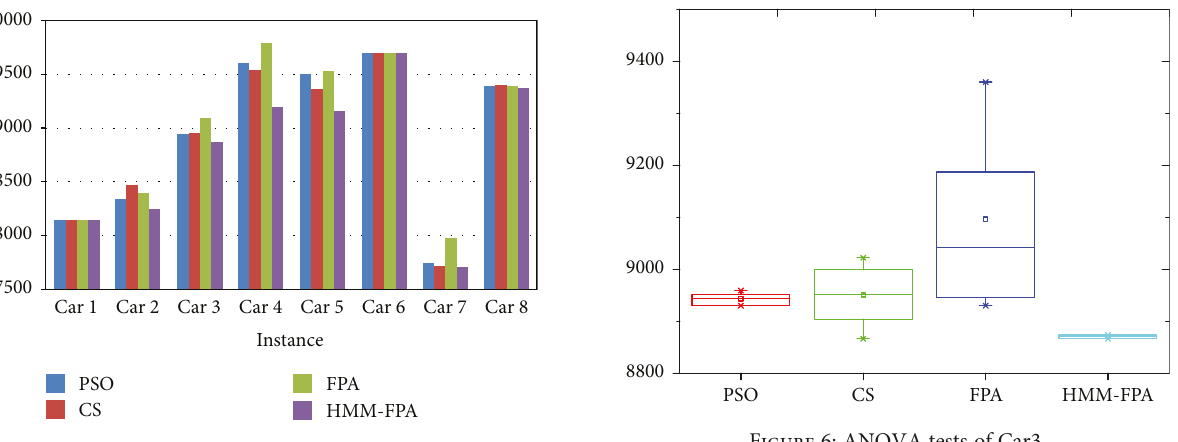
Figure 3: The makespan of the statistical results for the di ff erent